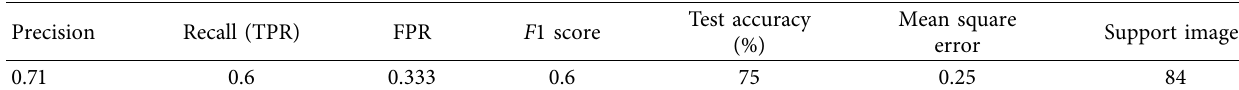
Figure 12: Naive Bayes classifcation confusion matrix. Table 5: NB classifer parameters.